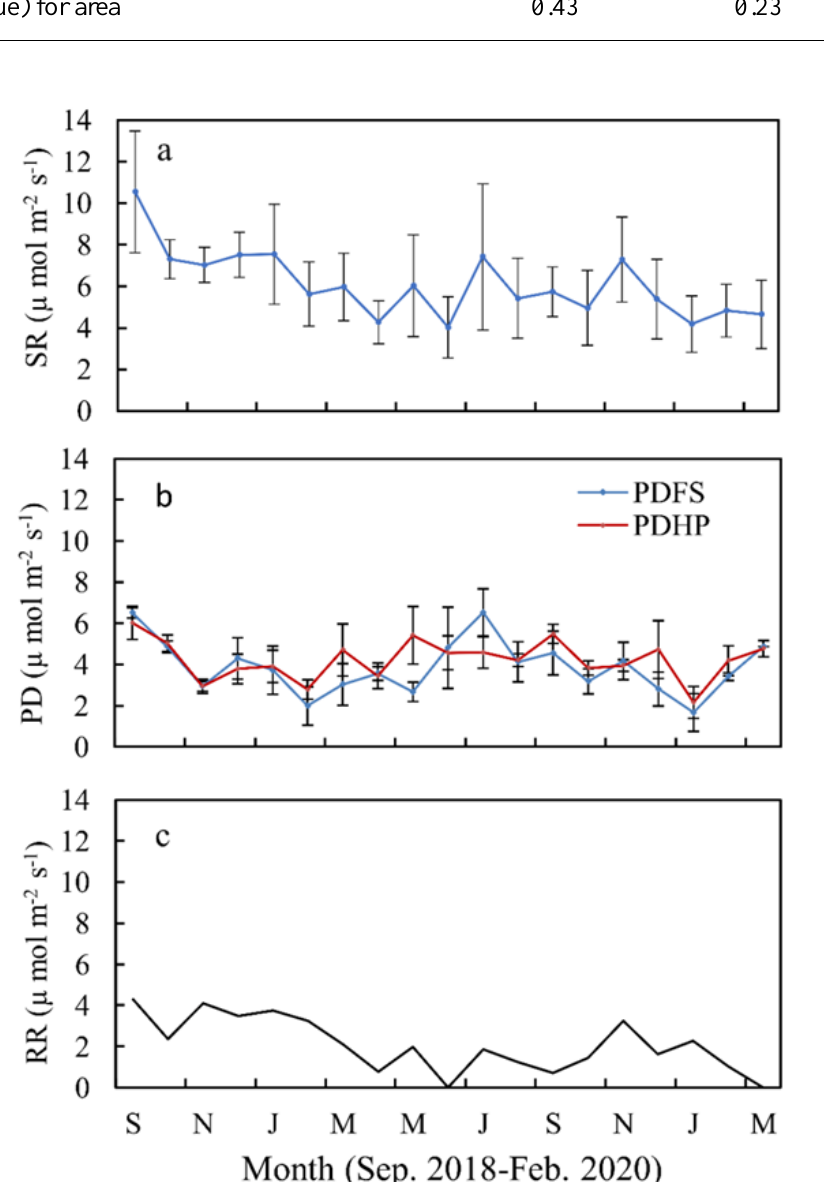
Figure 3. Mean seasonal variations in (a) total soil respiration (SR, in the root circle (RC) near the tree base, n = 3), (b) peat decomposition in the frond stack (PDFS) and in the harvesting path (PDHP) ( n = 3), and (c) residual between means of SR and PD that corresponds to root respiration (RR), from September 2018 to March 2020. Vertical bars denote one standard error